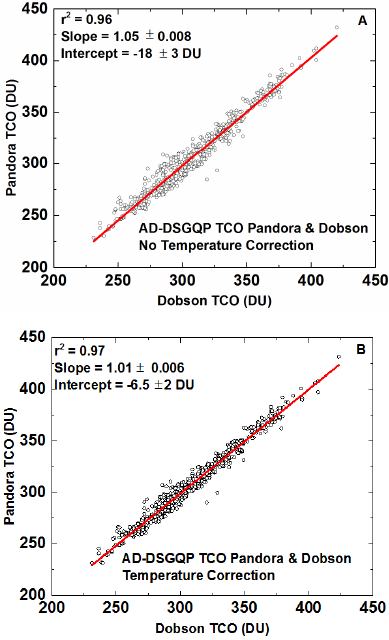
Figure 4. Scatterplot of Pandora TCO vs. Dobson TCO for clear- sky AD-DSGQP conditions: (a) no temperature correction and (b) with temperature correction.